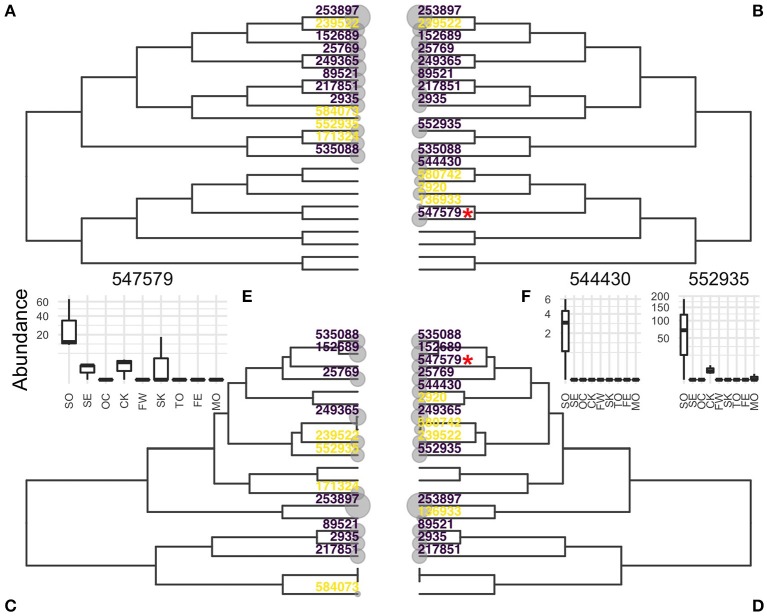
Evidences of OTUs estimated by hFDR with phylogeny (A,C) or correlation tree (B,D) represented on phylogeny (A,B) or correlation tree (C,D). OTUs detected as differential are colored in purple, those tested but not detected as differential in yellow. (E,F): Abundances of OTUs detected only by the correlation tree in different environments. OTU 547579 in (E) is highlighted with a red star in (B,D). Environment are abbreviated as SO, soil; SE, sediment; OC, ocean; CK, creek; FW, fresh water; SK, skin; TO, tongue; FE, feces; MO, mock.